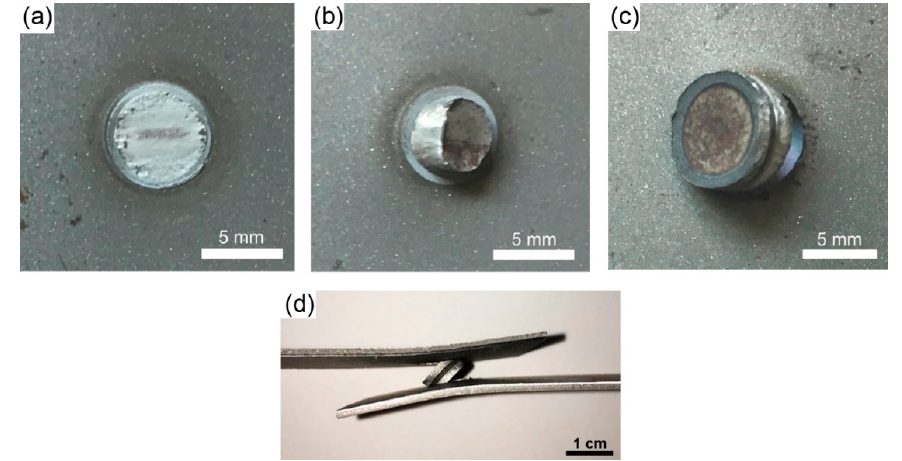
Figure 16. Macrostructures of failure mode: ( a ) Interfacial failure (IF); ( b ) partial thickness-partial pullout (PT-PP); ( c ) pullout failure (PF); ( d ) the side view of PF.